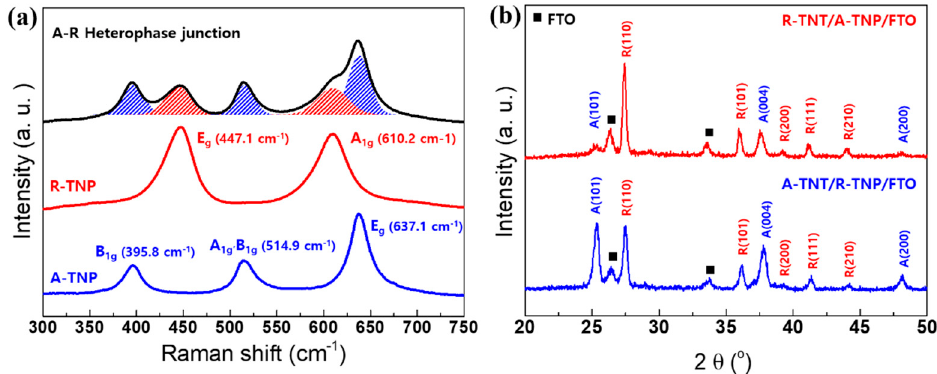
Figure 2. Structural characterizations of single-phase and heterophase TiO 2 nanostructured photoanodes: ( a ) Raman spectra of A-TNP, R-TNP, and R-TNT / A-TNP samples. ( b ) XRD patterns of photoanodes: ( a ) Raman spectra of A-TNP, R-TNP, and R-TNT/A-TNP samples. ( b ) XRD patterns of two di ff erent heterophase junctions with di ff erent anatase–rutile phase two different heterophase junctions with different anatase–rutile phase sequences.